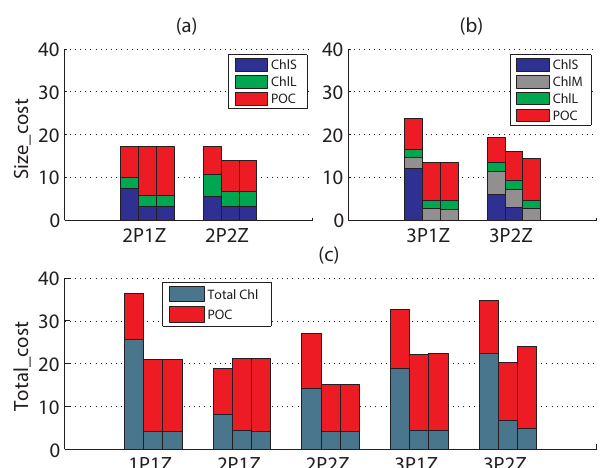
Figure 5. Cost functions at the five CV sites: (a) Size_cost for the 2P models, (b) Size_cost for the 3P models and (c) Total_cost for all five models. The three bars (from left to right) for each model represent the costs obtained for experiment 1 (a priori cost), exper- iment 2 (a posteriori cost) and experiment 3 (a posteriori case with noise), respectively. Colors represent the various components (total chlorophyll, size-fractionated chlorophyll and POC) of these costs.